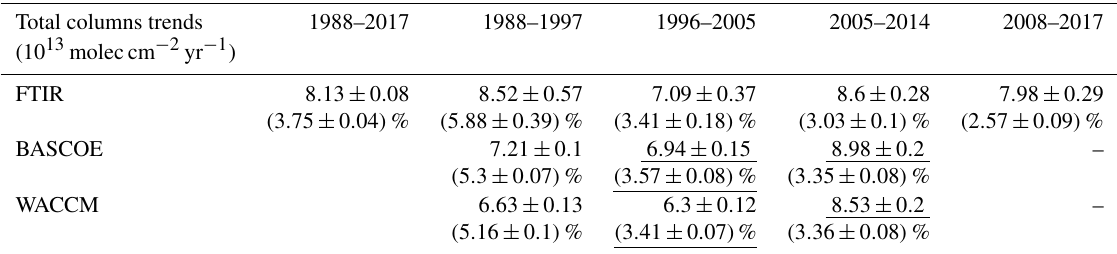
Table 2. HCFC-22 total columns trends over JFJ. The uncertainties are given for the 2 σ level following the Santer et al. (2000) approach. Models trends are underlined when not significantly different from observations. Relative trends (%yr − 1 ) are given with respect to the yearly mean of the middle year of the considered period.